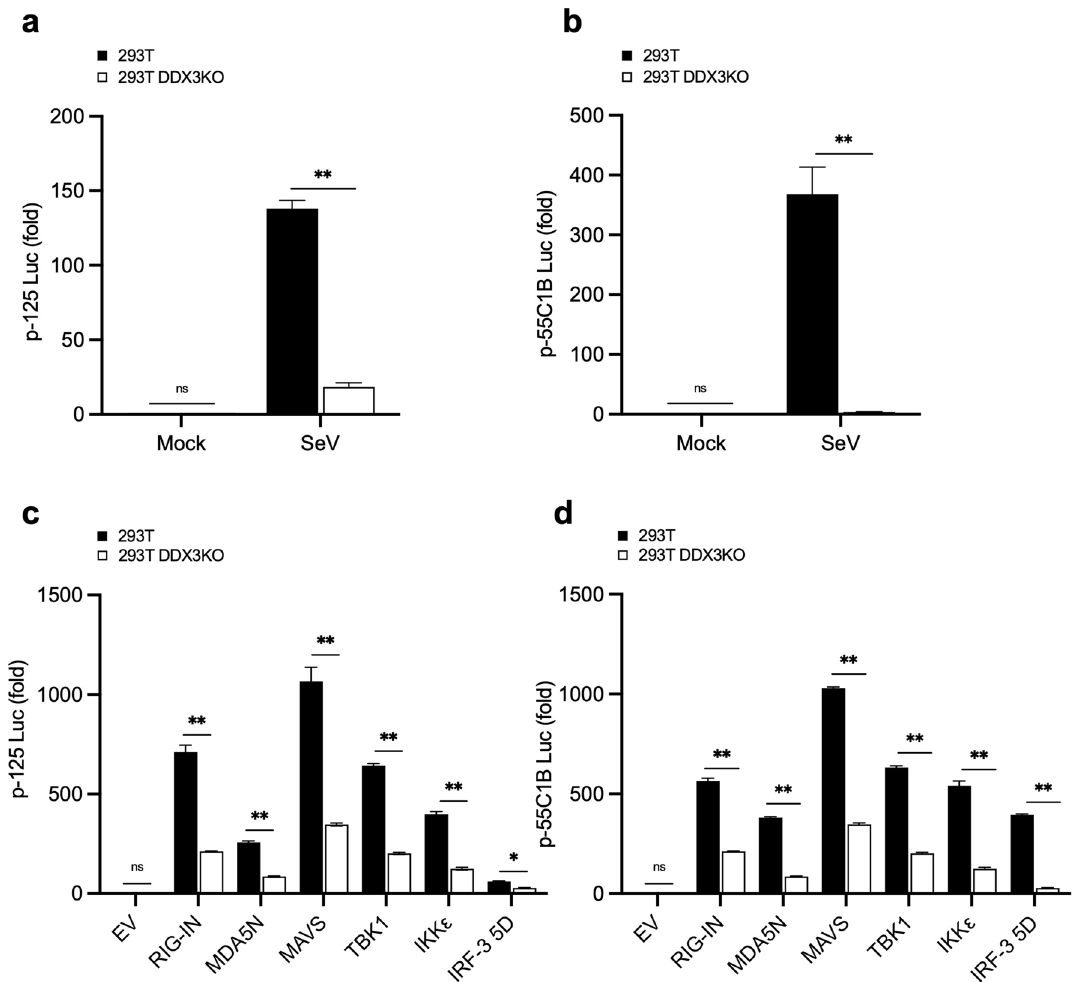
Figure 2. Effects of the absence of DDX3 on IFNB reporter gene expression stimulated by SeV or by expression of constitutive active signaling adaptors. 293T and 293T DDX3KO cells were transiently transfected with a reporter gene driven by IFNB promoter (p-125Luc, a ) or reporter constructs containing repeated IRF-binding motifs (p-55C1BLuc, b ) together with internal control (pRL-TK) plasmid for 24 h, followed by stimulation by infection with SeV for 12 h. Data represent relative firefly luciferase activity normalized to the internal control. 293T and 293T DDX3KO cells were transiently transfected with reporters ( c : p-125Luc; d : p-55C1BLuc). Cells were simultaneously stimulated by co-transfection with expression vectors for RIG-IN, MDA5N, MAVS, TBK1, IKK ɛ , or IRF-3 5D for 24 h. Cells were subjected to dual luciferase assay. Data are presented as relative firefly luciferase activity normalized to Renilla luciferase activity. Data are presented as the mean ± SEM and are one representative of 3 independent experiments. Data were analyzed using two-way ANOVA with Sidak’s post-test ( a – d ). * p < 0.05, ** p < 0.001. ns, not